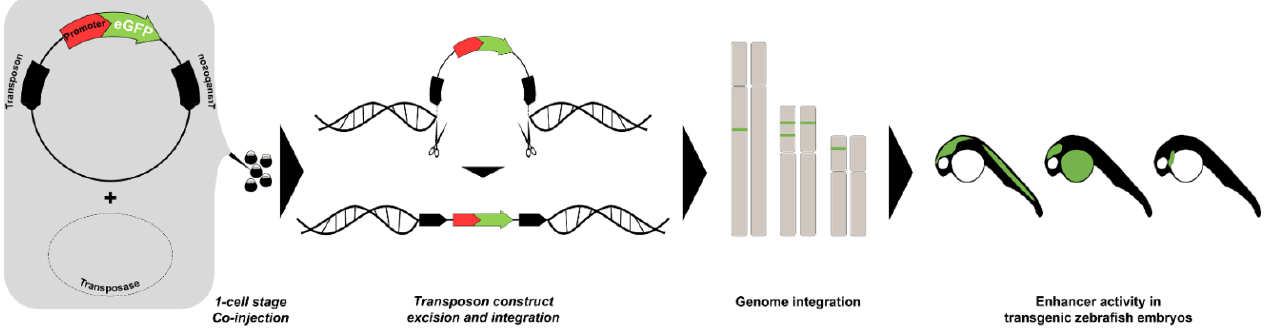
Figure 1. Enhancer trapping method. The synthetic transposase mRNA, the transposon donor plasmid containing transposable elements with a minimal promoter, and the gene encoding green fluorescent protein (GFP) are co-injected into fertilized zebrafish eggs. The construct is excised from the donor plasmid and integrated into the endogenous genome. The activity of the “trapped” enhancer can be visualized in the injected embryo when the inserted transgene is expressed under control of nearby enhancers.